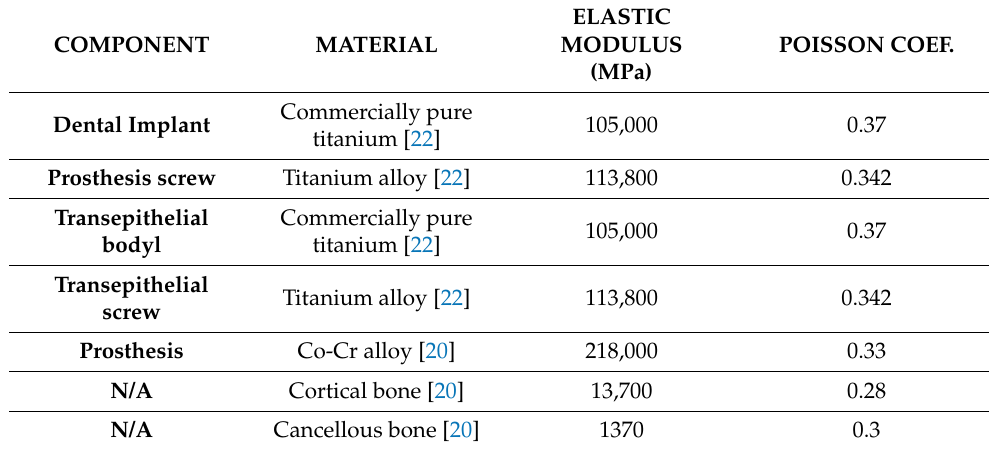
Table 1. Material properties of the components used in the finite element models.